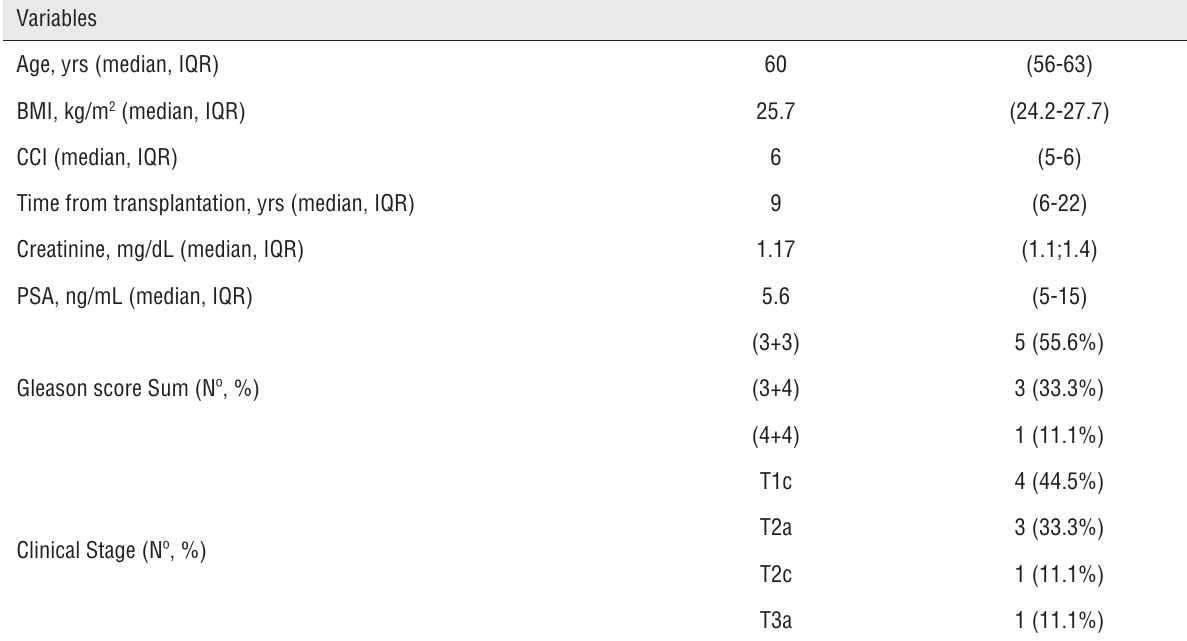
Table 1-Robotic and assistant port positioning for T-RARP.